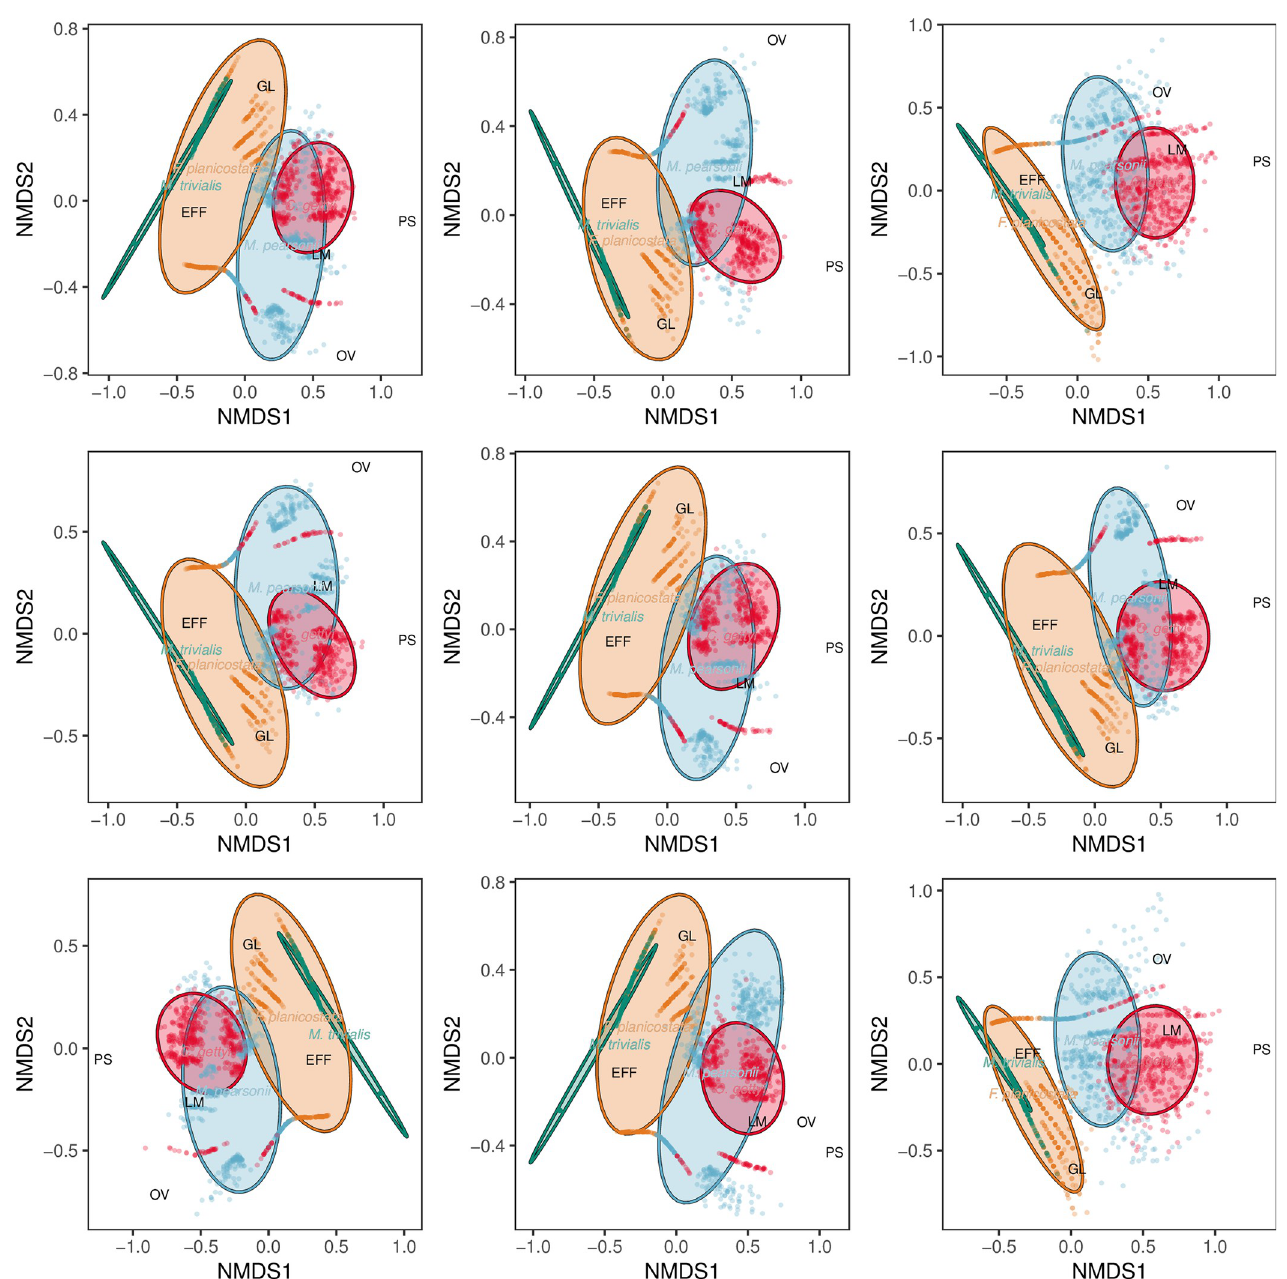
Fig 18. Non-metric multidimensional scaling (NMDS) ordination subsampled at 140,000 mm 2 . This ordination includes elipses, which denote 84% of the datapoints closest to the centroid, for Catula gettyi and three Hell Creek taxa ( Marmarthia pearsonii , M . trivialis , and “ Ficus ” planicostata